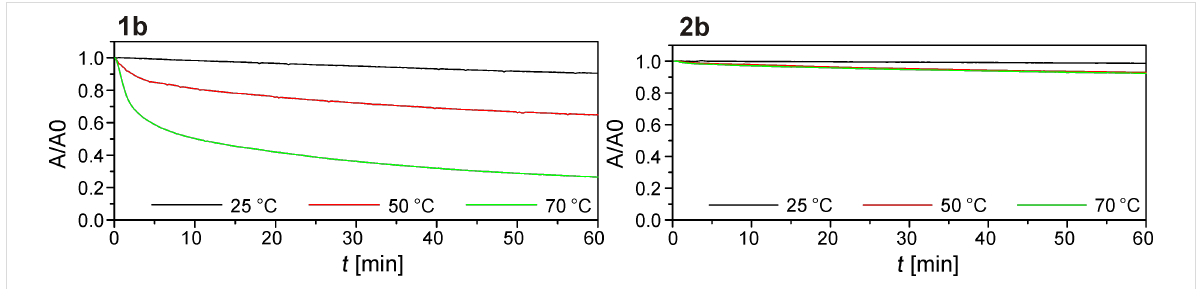
Figure 5: Thermostability measurements of the 7-deazaadenosine nucleosides. A 60 µM solution of the compound in acetonitrile was irradiated with UV light until the (pseudo)-photostationary state was reached. Then UV irradiation was switched off and the absorption at the visible light maximum of the closed ring form was measured over 1